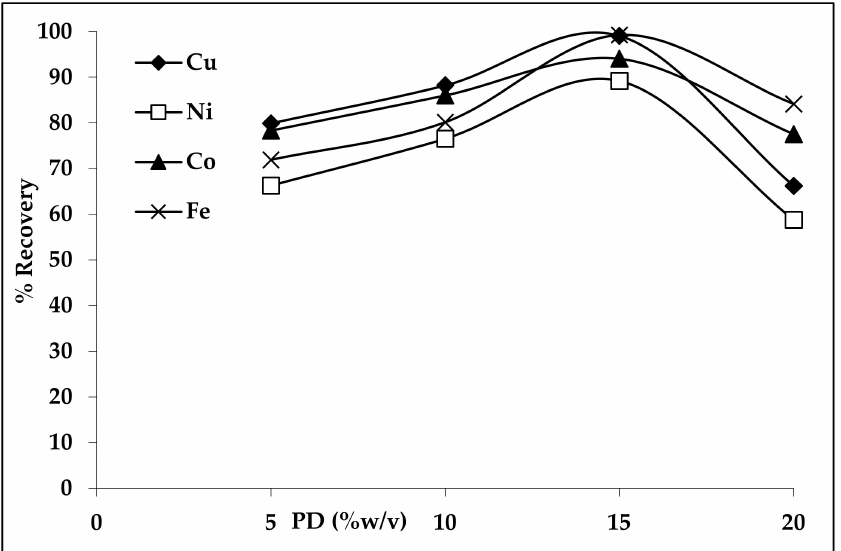
Figure 9. E ff ect of pulp density on recovery of Cu, Ni, Co, and Fe at 308 K using 2 N citric acid for 15